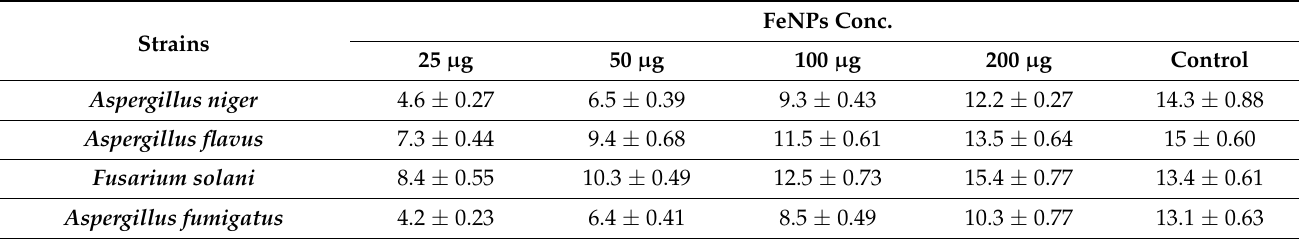
Table 2. Antifungal potential of FeNPs against selected fungal strains.